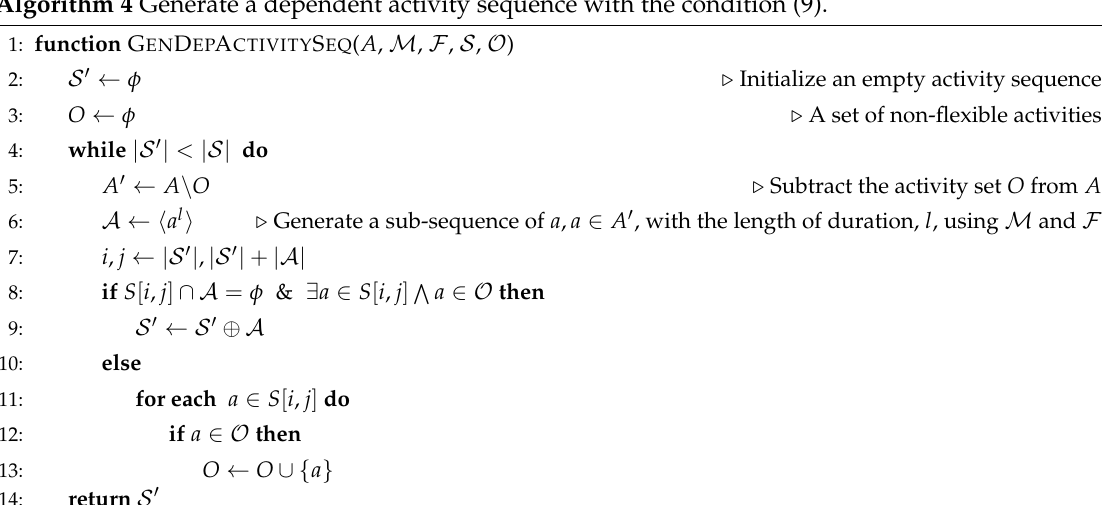
Algorithm 4 Generate a dependent activity sequence with the condition